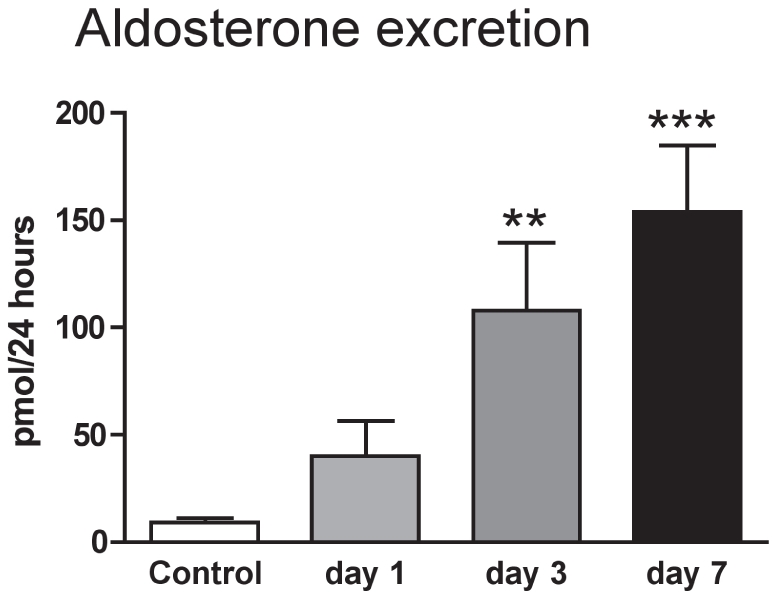
24-hour urinary excretion of aldosterone.Urine was collected from conscious cyp1a1-Ren2 transgenic rats (n = 8) maintained in individual metabolism cages, over consecutive days of transgene induction. Data are mean ± SE. Statistical comparisons were made using ANOVA with Bonferroni post-test. ***P<0.001, **P<0.01 versus the control day.